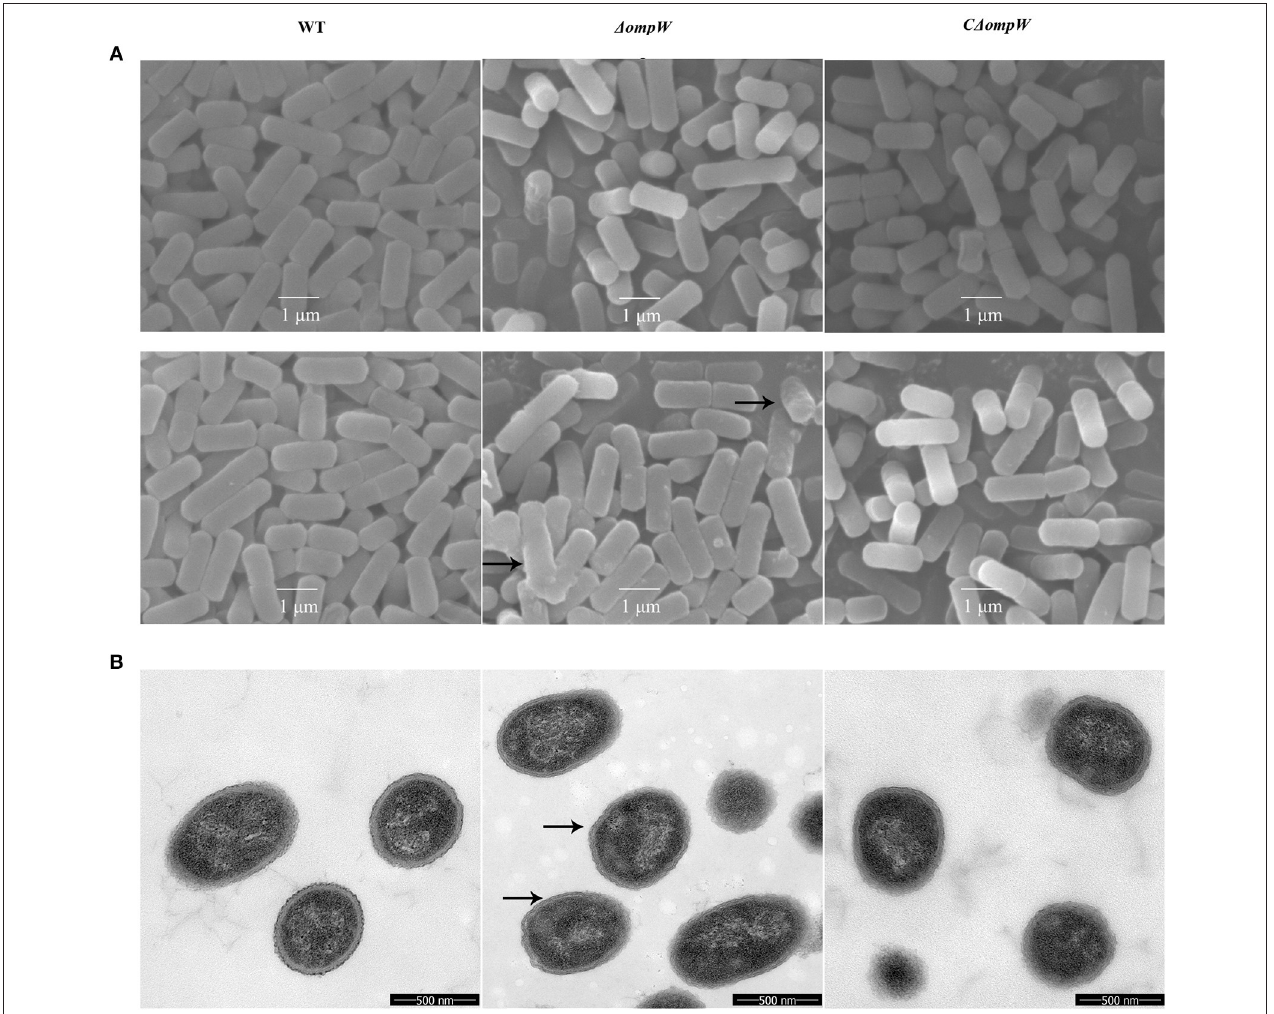
FIGURE 3 | (A) SEM and (B) TEM morphology of the A. pleuropneumoniae, 1 ompW mutant strain, and C 1 ompW strain during logarithmic and steady state